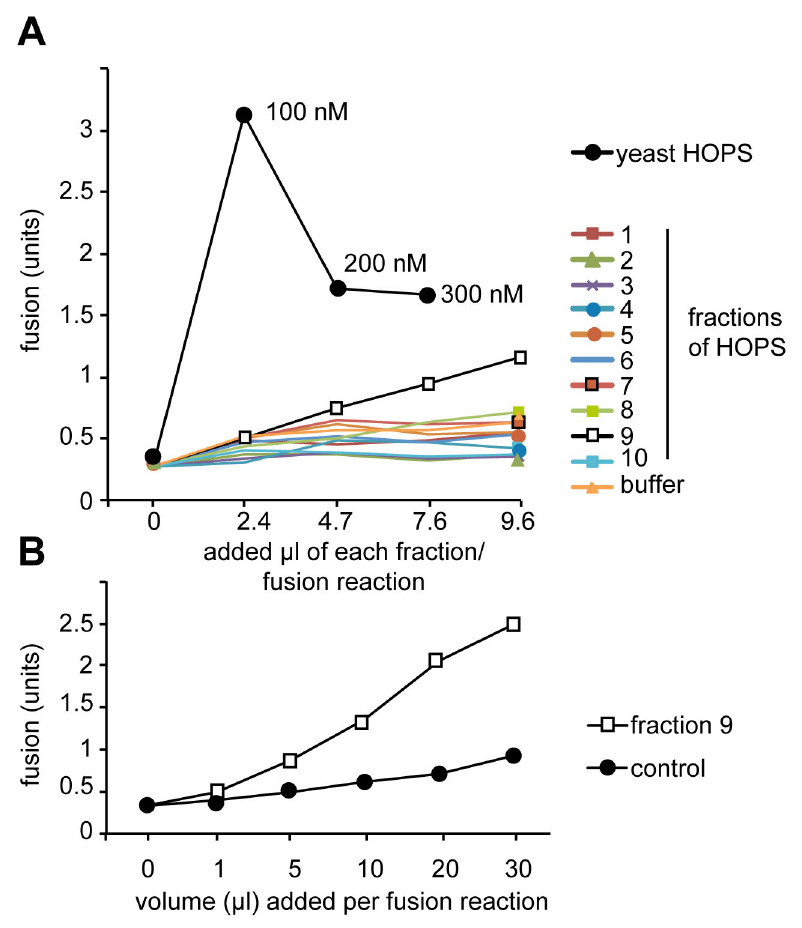
Figure 3. Recombinant HOPS can support vacuole fusion. Vacuoles were purified from each of the two tester strain ( pep4 ∆ and pho8 ∆) that each carry the vps11-1 mutation (Stroupe [29]and Wickner, 2006). Fusion reactions (30 µl total) contained 3 µg of each vacuole type in fusion salt (0.5 mM MgCl , 125 mM KCl, 20 mM PIPES/KOH, pH 6.8, 200 mM sorbitol) and an ATP- 2